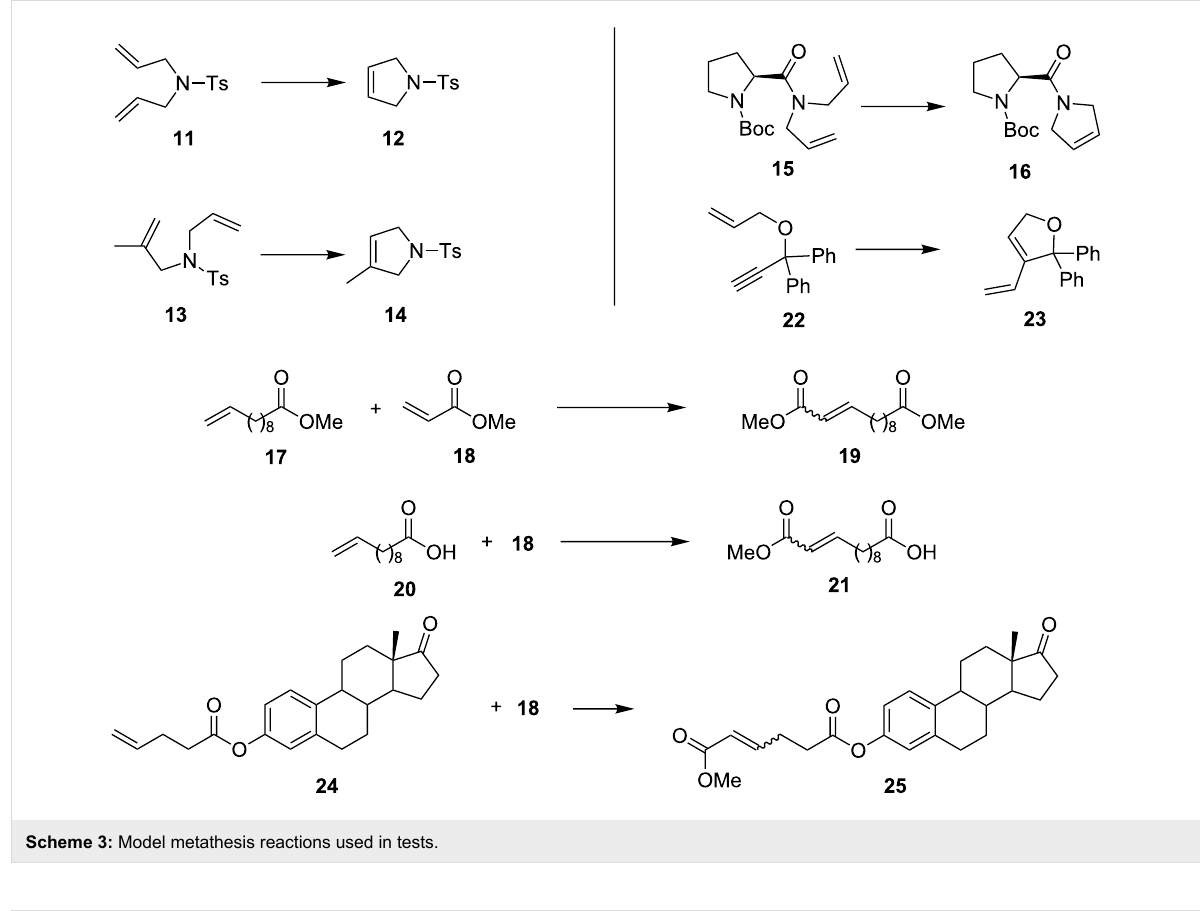
Scheme 3: Model metathesis reactions used in tests.